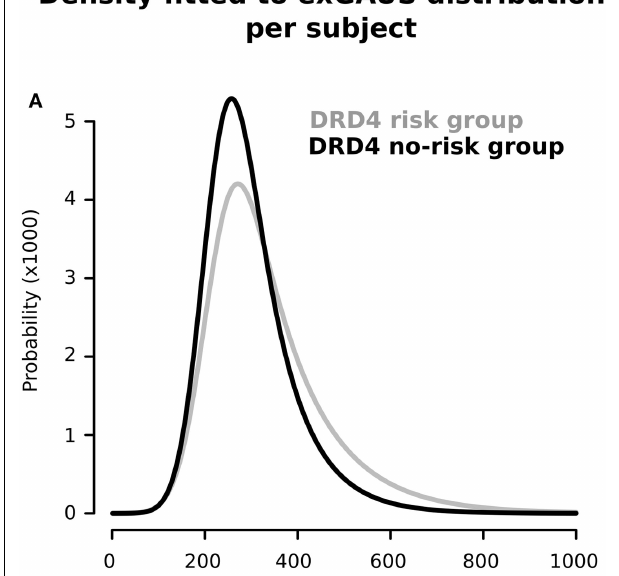
Table 1 | Summary of estimated effects in general linear models adjusted for mu, sigma, and tau parameters .